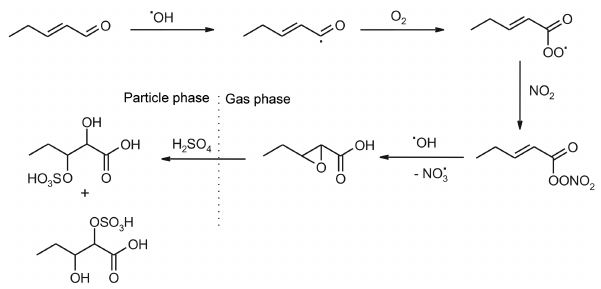
Scheme 4. Proposed formation pathway for m/z 213